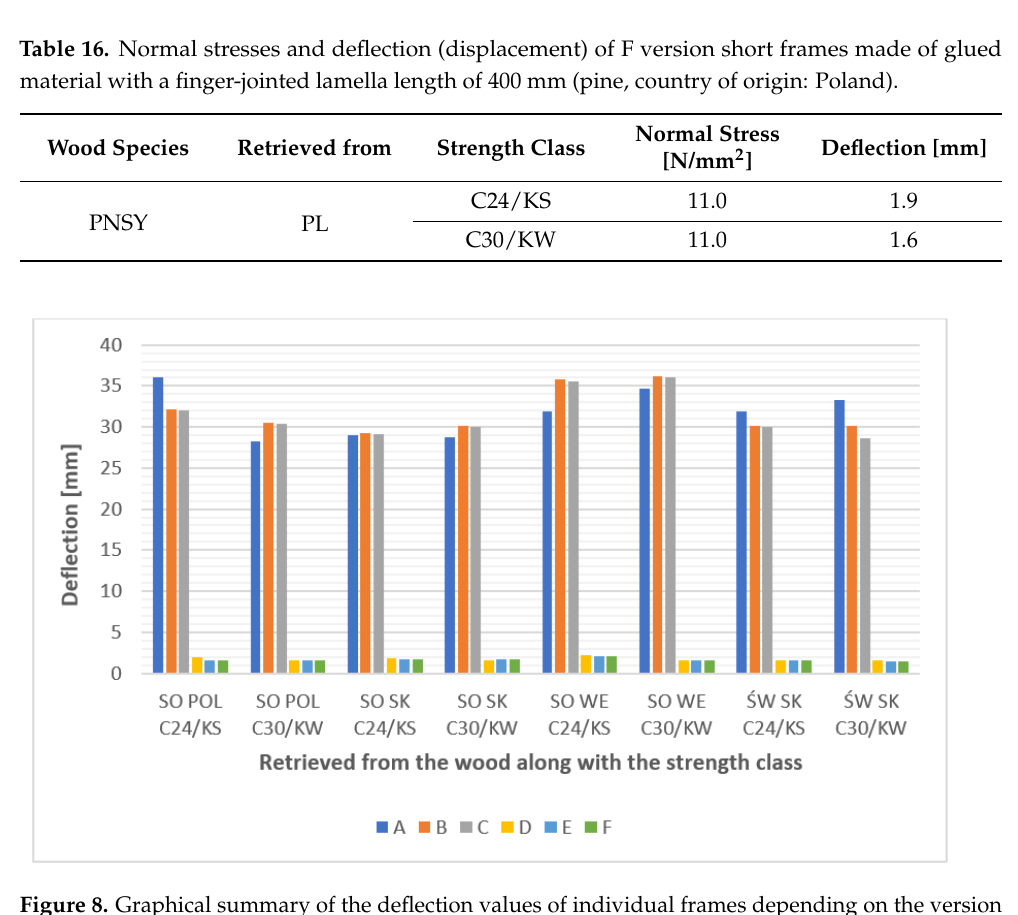
Figure 8. Graphical summary of the deflection values of individual frames depending on the ver- sion (A – F) and the origin of the wood and the strength class of the material. (A–F) and the origin of the wood and the strength class of the